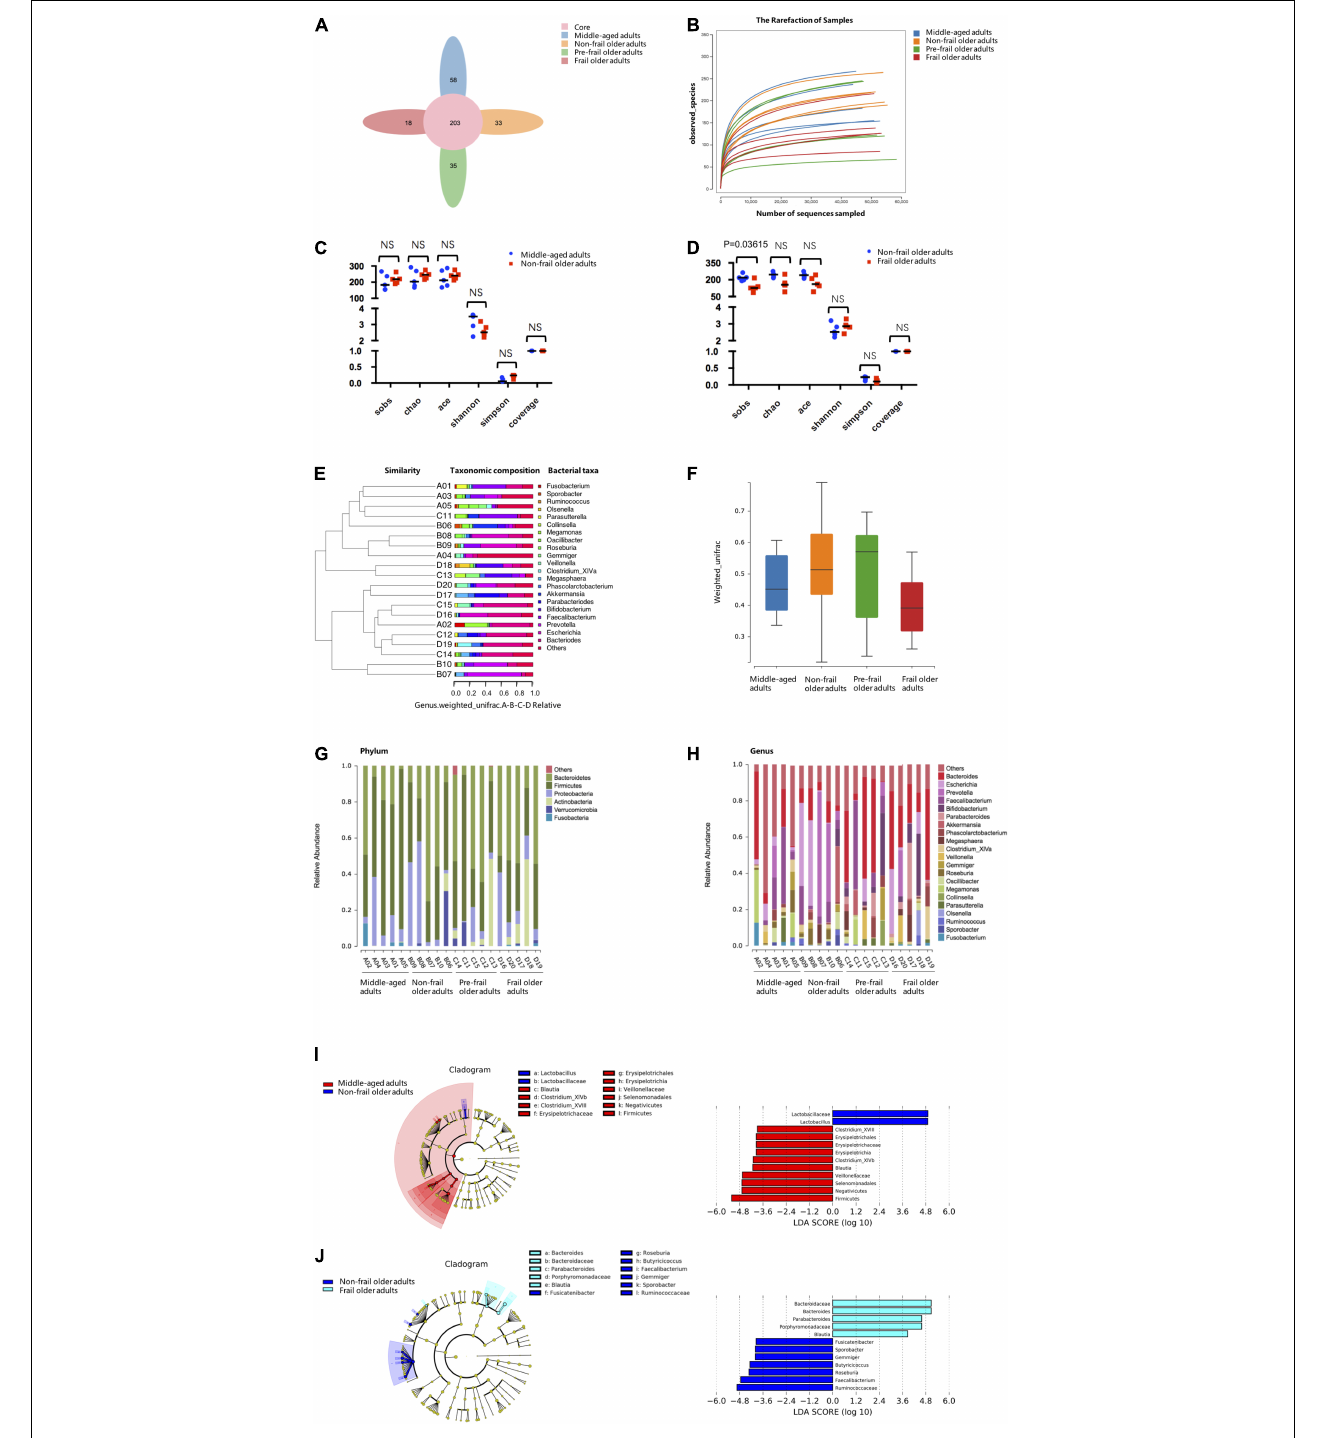
FIGURE 4 | 16S rDNA-amplicon sequencing analysis. (A) The Core-Pan diagram of OTUs distribution among four groups. (B) The rarefaction curve of random sequences per sample and their corresponding number of observed species. (C,D) Species diversity differences estimated by the observed Sobs, Chao, Ace, Shannon, Simpson, and coverage indices. (E) UPGMA cluster analysis of 20 samples at genus level. A01, A02, A03, A04, and A05 represented middle-aged group; B01, B02, B03, B04, and B05 represented non-frail group; C01, C02, C03, C04, and C05 represented pre-frail group; D01, D02, D03, D04, and D05 represented frail group. (F) Beta diversity box-plot based on weighted UniFrac analysis among groups. (G) The percentages of gut microbiota diversity at phylum level. (H) The percentages of gut microbiota diversity at genus level. (I,J) LDA integrated with effect size (LEfSe). Left: the phylogenetic distribution of microbiota in cladogram. Right: the differences in abundance of microbiota. Middle-aged adults vs. non-frail subjects (I) ; non-frail subjects vs. frail subjects (J) . NS, not significant.